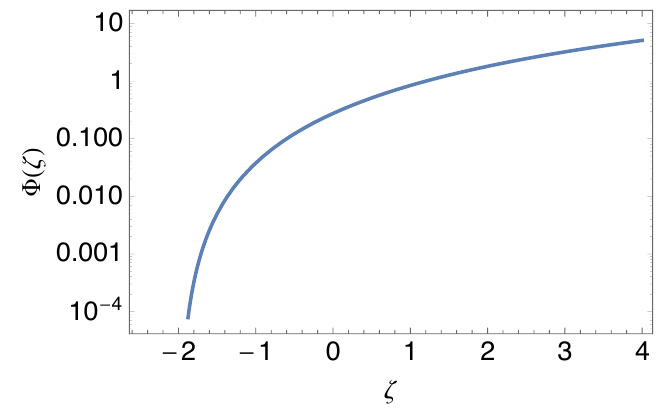
Figure 2 . Dean and Majumdar’s rate function (cid:8)( (cid:16) ) de(cid:12)ned in eq. (2.8). The rapid growth of (cid:8) away from (cid:16) = 2 implies an exponential suppression of the probability of occurrence of such (cid:0) spectra in Gaussian